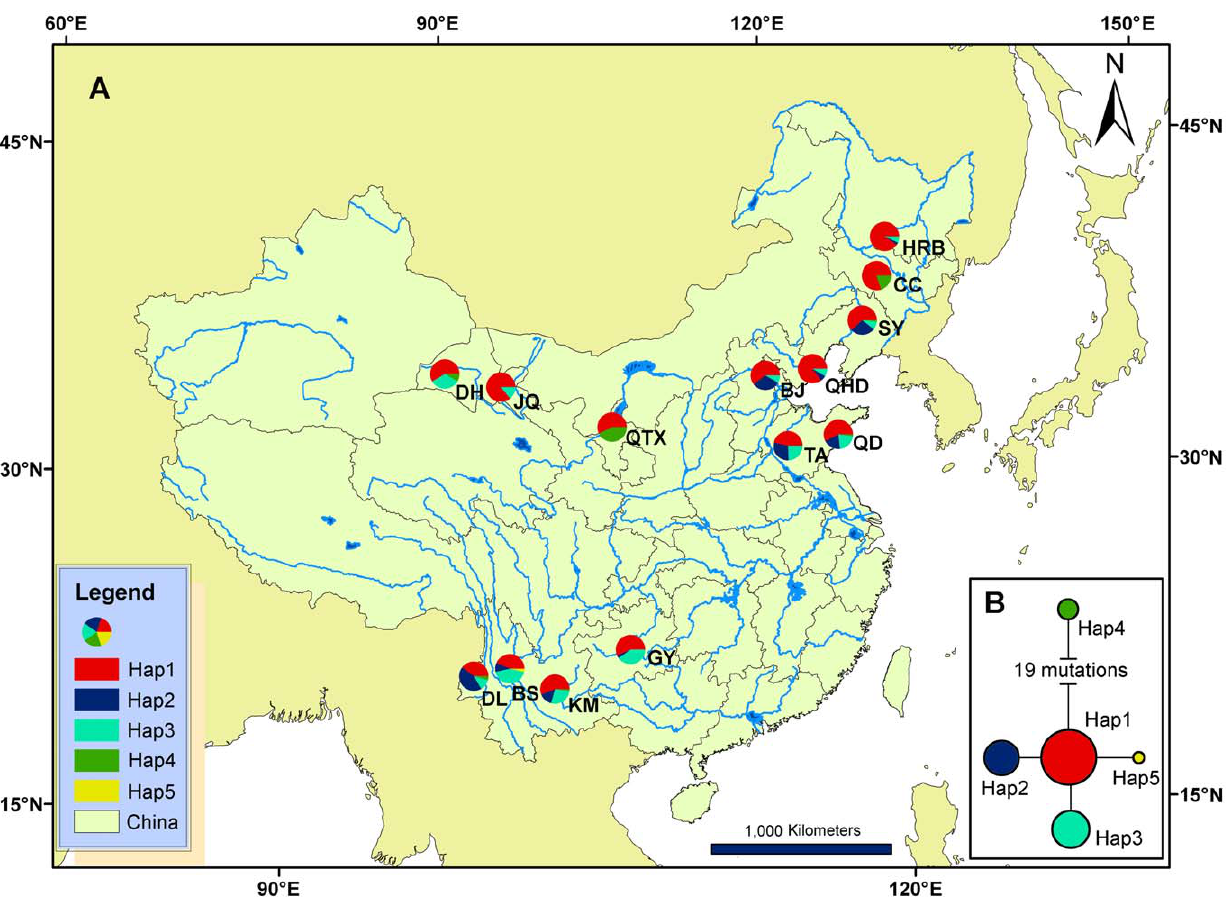
Figure 1. Sampling sites and haplotype frequencies in the examined populations of F.occidentalis . (A) Haplotype frequencies of COI in 14 populations in China. The abbreviations and coordinates of collection sites are shown in Table 1. (B) Haplotype network based on mitochondrial COI sequence. Frequency of haplotype is proportional to circle area. Each line between circles represents one mutational event.